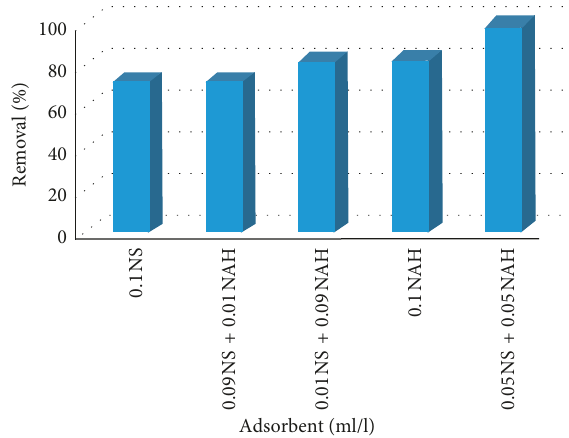
Figure 11: The effect of NS, GNPs, and NSG nanocomposite on the adsorption of 10mg · L − 1 EBTdye at a pH of 3 and a contact time of